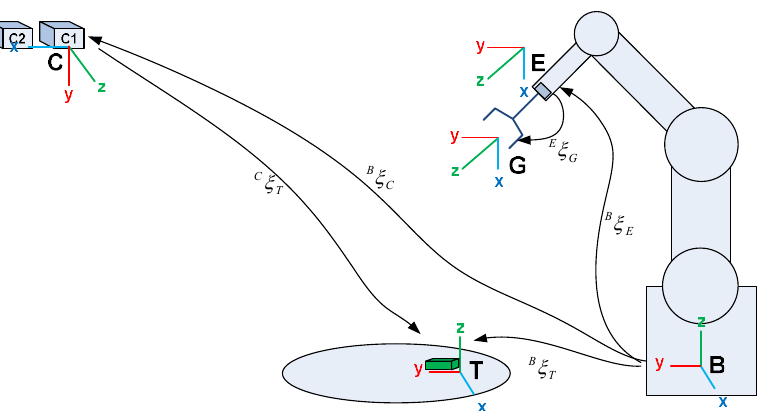
Figure 3. Coordinate transformation relationship.